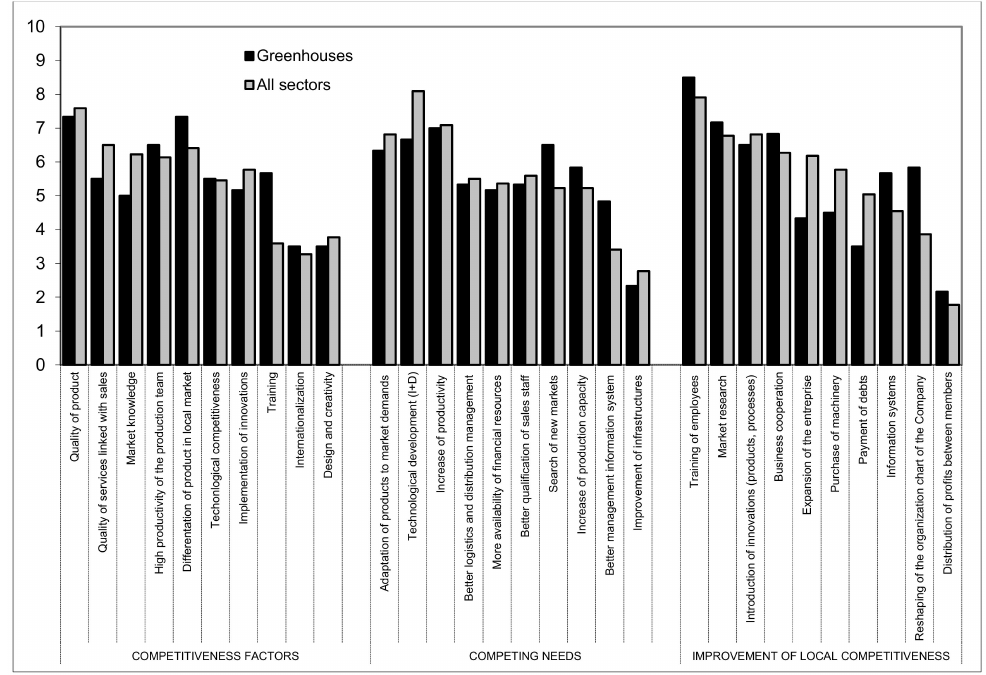
Figure 5. Issues related to competitiveness of the infrastructures of greenhouses with regards to other